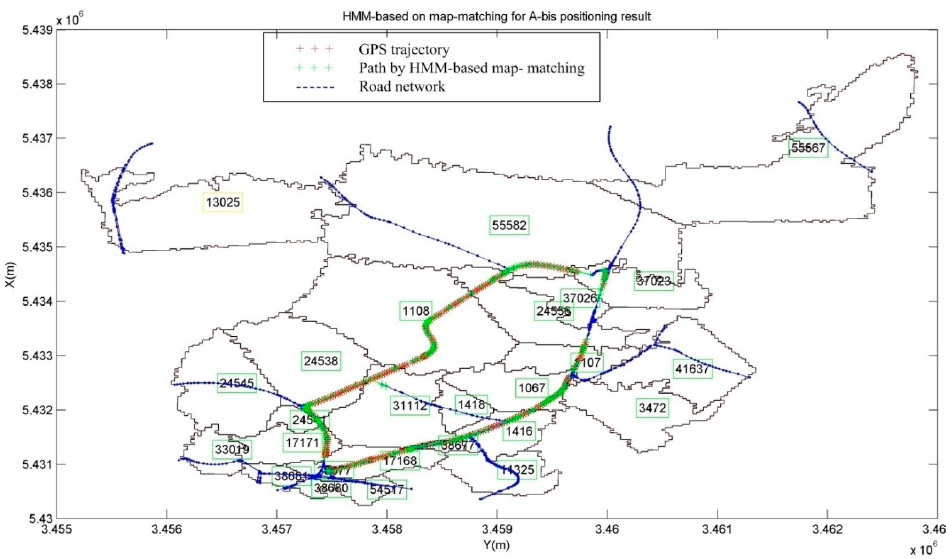
Figure 14. HMM-based on map-matching for A-bis positioning result.